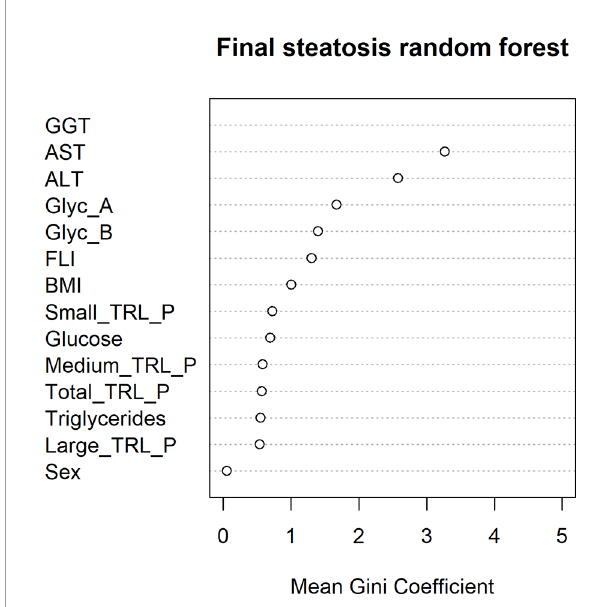
FIGURE 4 | Random forest mean Gini Coef fi cient for each variable in order to study their importance in the classi fi cation of ultrasound-con fi rmed hepatic steatosis after a 10 years ’